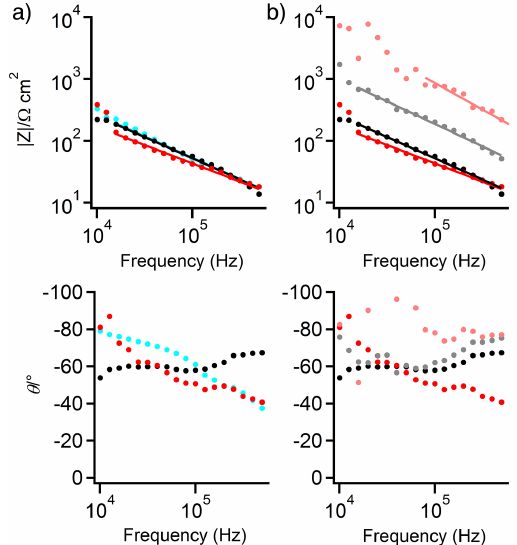
Figure 4. ( a ) Impedance modulus and phase plots of aged wax on the two different bronze sculptures, with the spectra displayed as solid circles for PPU (aqua), C1 (black), and C2 (red) and equivalent circuit fits included as solid lines in their same respective colors; ( b ) Bode plot comparison between the two areas measured on the chair before (C1, C2) and after (C1b, C2b) the annual wax reapplication. C1 and C2 are depicted in the same colors as in (a) along with C1b (gray) and C2b (pink) and their corresponding Constant Phase Elements (CPE) fit lines.